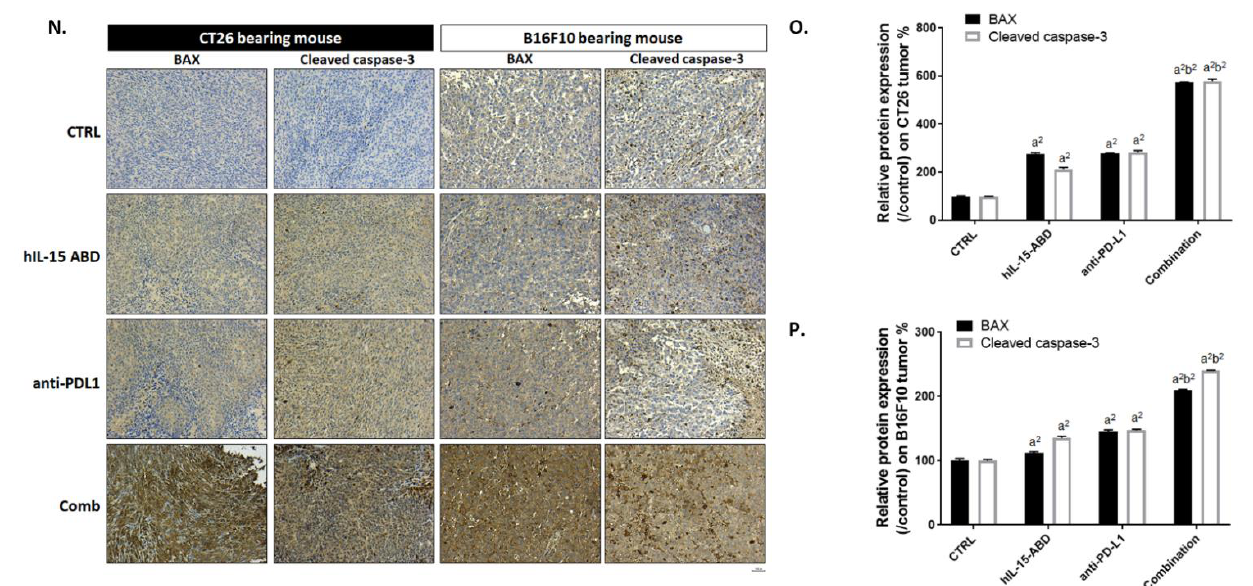
Figure 4. hIL15-ABD facilitated anti-tumor efficacy of anti-PD-L1 antibody via enhancing apoptosis mechanism. ( A ) Animal flow chart of hIL15-ABD, anti-PD-L1 and combination treatment is presented. ( B , C ) Colon cancer (CC) tumor growth from day 0–18 and tumor photographed on day 21 are displayed. ( D , E ) Melanoma tumor growth from day 0–18 and tumor photographed on day 21 are displayed. Tumor weight from ( F ) CC and ( G ) melanoma on day 18 are summarized. ( H ) BLI and ( I ) quantification results from B16-F10/ luc2 bearing mice are presented. Mice body weight from ( J ) CC ( K ) melanoma model is recorded every 3 days during therapy. ( M , N ) IHC staining images and ( L , O , P ) relative proteins quantification level on CC and melanoma are presented. (a 1 p < 0.05, a 2 p < 0.01 vs. CTRL; b 1 p < 0.05, b 2 p < 0.01 vs. hIL15-ABD and anti-PD-L1; scale bar = 100 μm).